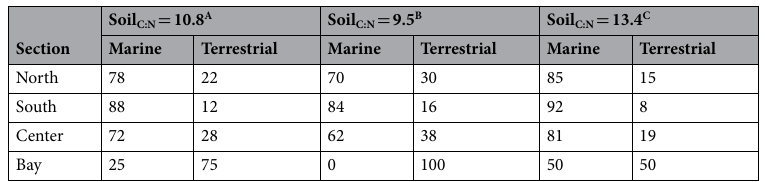
Table 3. Relative contributions (%) of marine and terrestrial sources using different soil C:N ratios as the end- member. A, B and C presented the soil C:N in our study, in the lower Yellow River Basin and in the Chinese Loess Plateau,